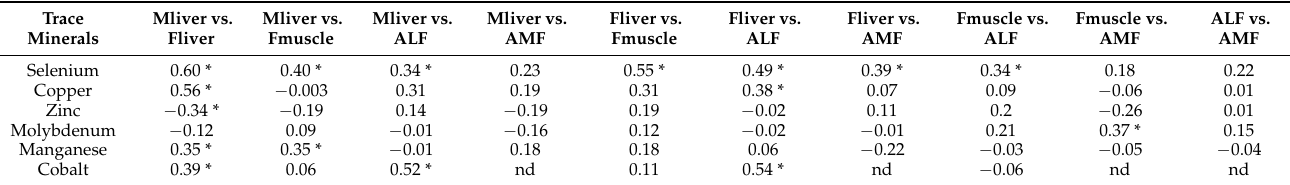
Table 7. Correlation coefficients for individual trace minerals between maternal liver (Mliver), fetal liver (Fliver), fetal muscle (Fmuscle), allantoic (ALF), and amniotic (AMF) fluids from beef heifers